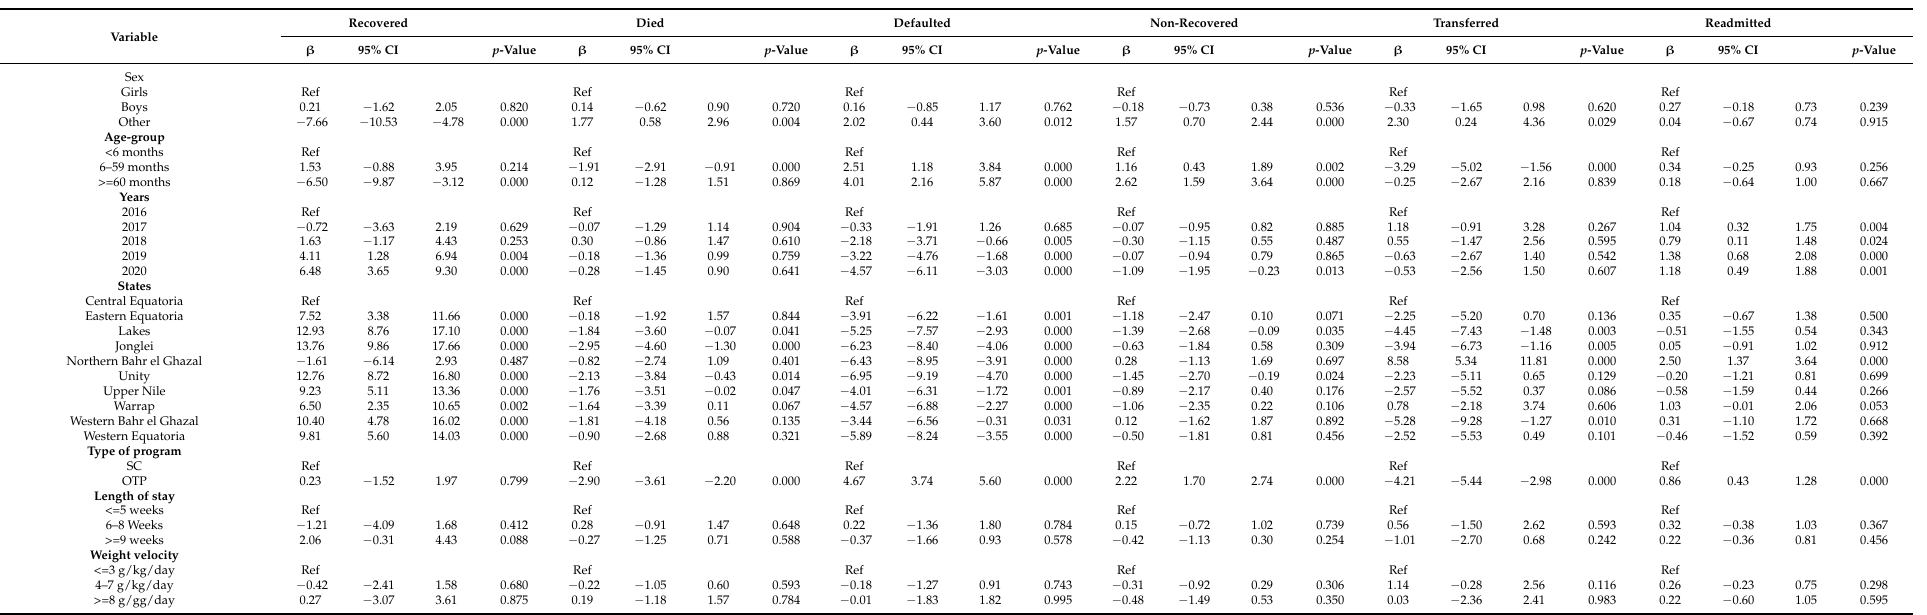
Table 4. Unadjusted models exploring factors associated with exit outcome indicators and